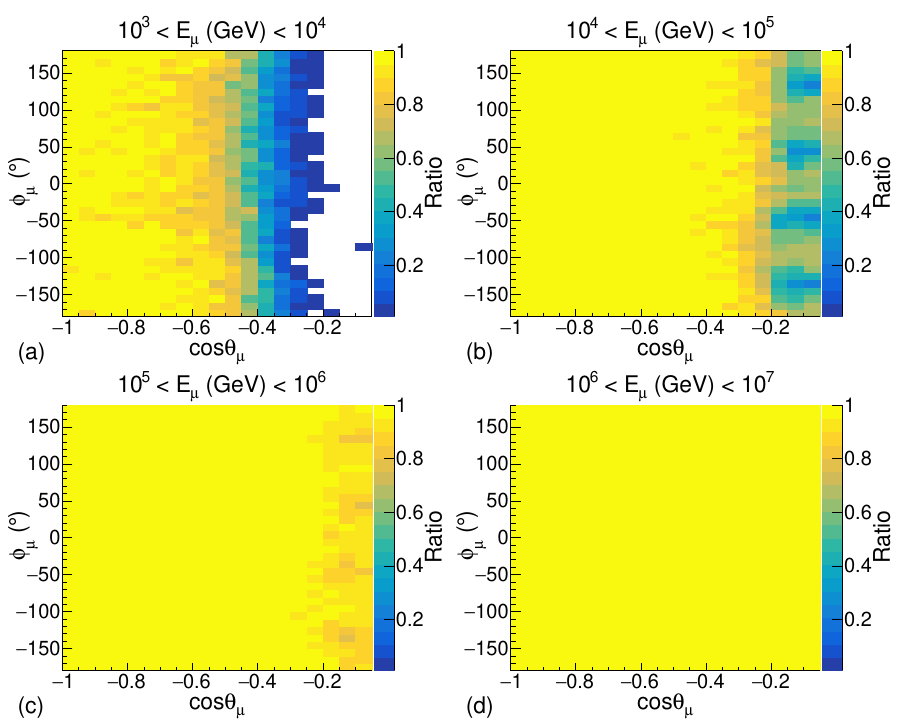
Figure 5. The ratio of the number of muons detected to the number of muons generated in the simulation without the shore with respect to the muon arrival direction for energy ranges: ( a ) 10 3 – 10 4 GeV, ( b ) 10 4 –10 5 GeV, ( c ) 10 5 –10 6 GeV, and ( d ) 10 6 –10 7 GeV.